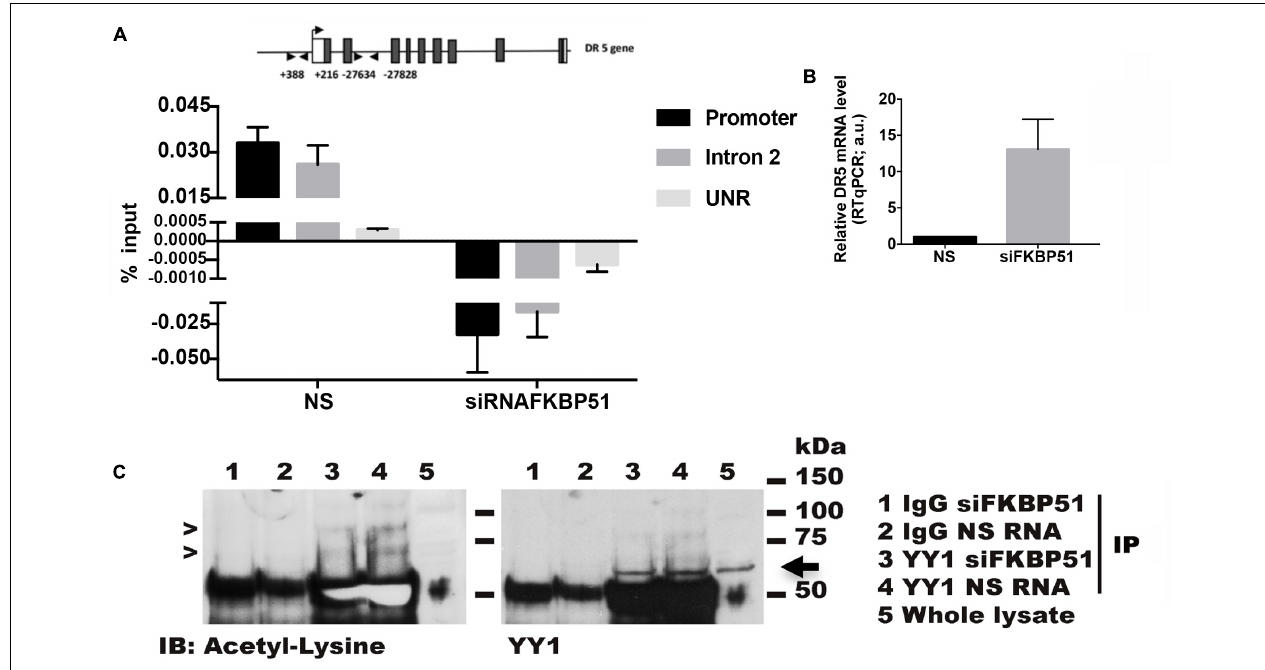
FIGURE 4 | FKBP51 silencing affects Yin Yang 1 (YY1) binding on DR5 gene and its lysine acetylation status. (A) ChIP assay performed with an anti-YY1 antibody in A375 cells silenced for FKBP51 (siFKBP51) or control cells (NS). Quantitative RT-qPCR analysis was performed using primers covering YY1 putative binding sites in promoter and intron regions of the DR5 gene. An unrelated region (UNR) was used as a negative control. The histogram shows the amount of DNA immunoprecipitated by using YY1 antibody subtracting the amount of background IgG, both calculated relative to the input DNA ( N = 3). (B) DR5 expression levels were analyzed by RT-qPCR (right panel). (C) YY1 was immunoprecipitated in siRNAFKBP51 and NS cells with anti-YY1 antibody or control immunoglobulin (IgG), as indicated. After immunoprecipitation, Western blot analysis was performed with antiacetyl lysine antibody (left panel). The arrows indicate acetylated YY1. The amount of immunoprecipitated YY1 was visualized by Western blot analysis with anti-YY1 antibody (right